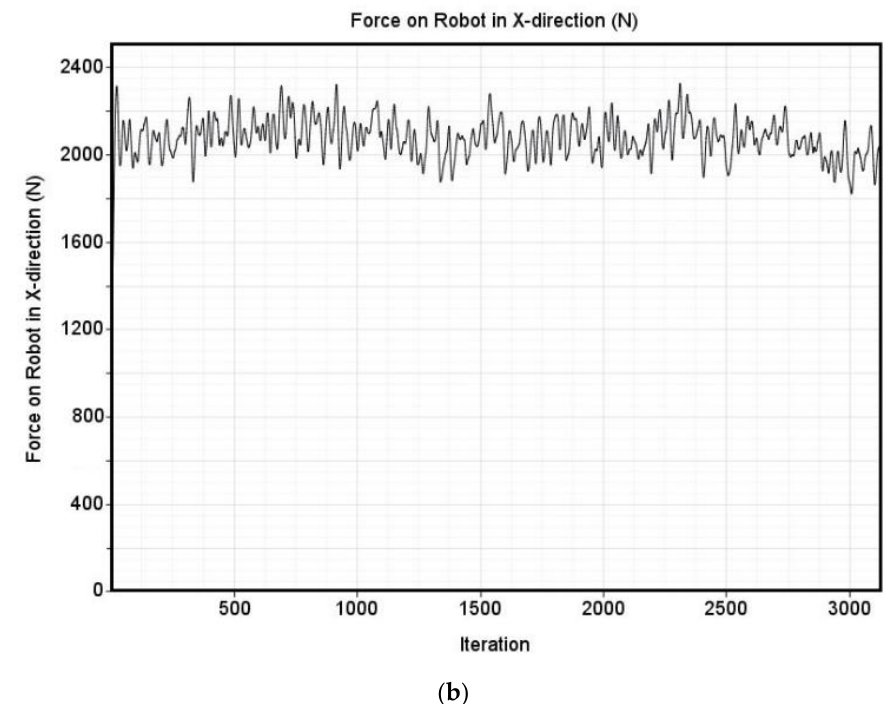
Figure 19. Drag force evaluation on ( a ) leg. ( b ) Robot body.